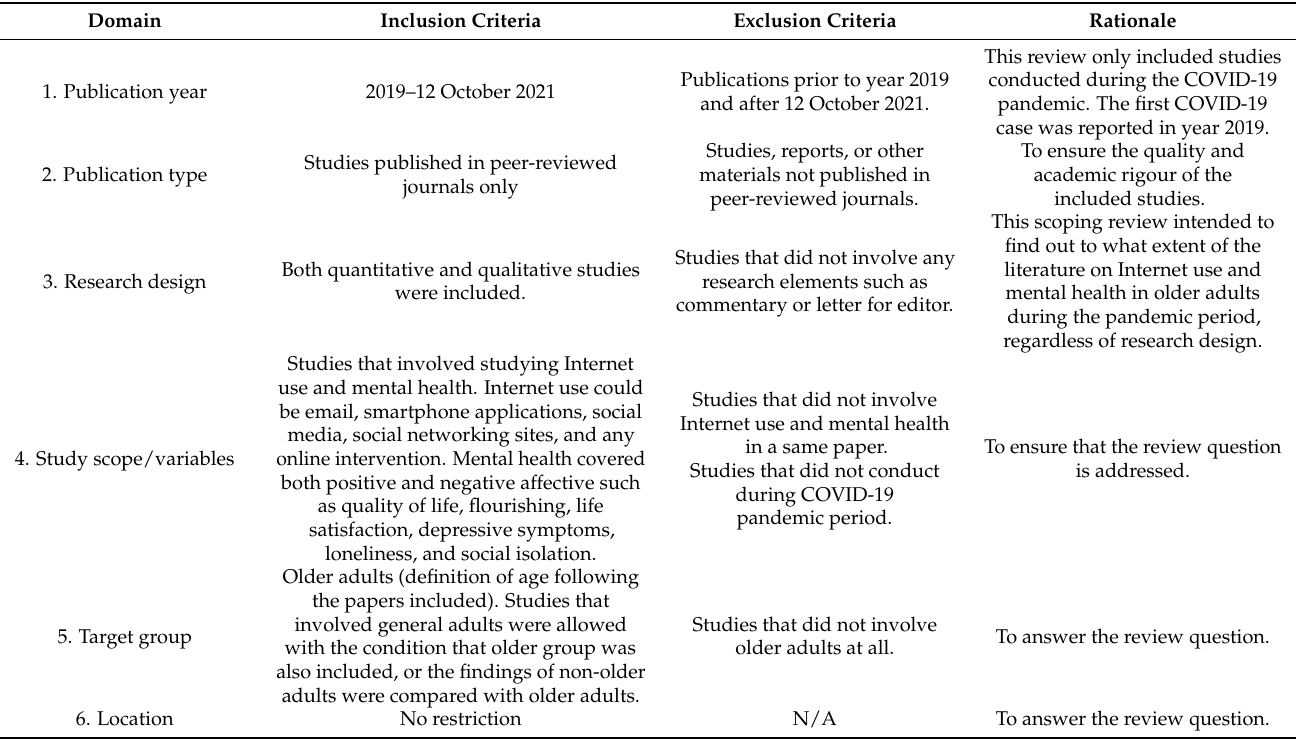
Table 2. Inclusion and exclusion